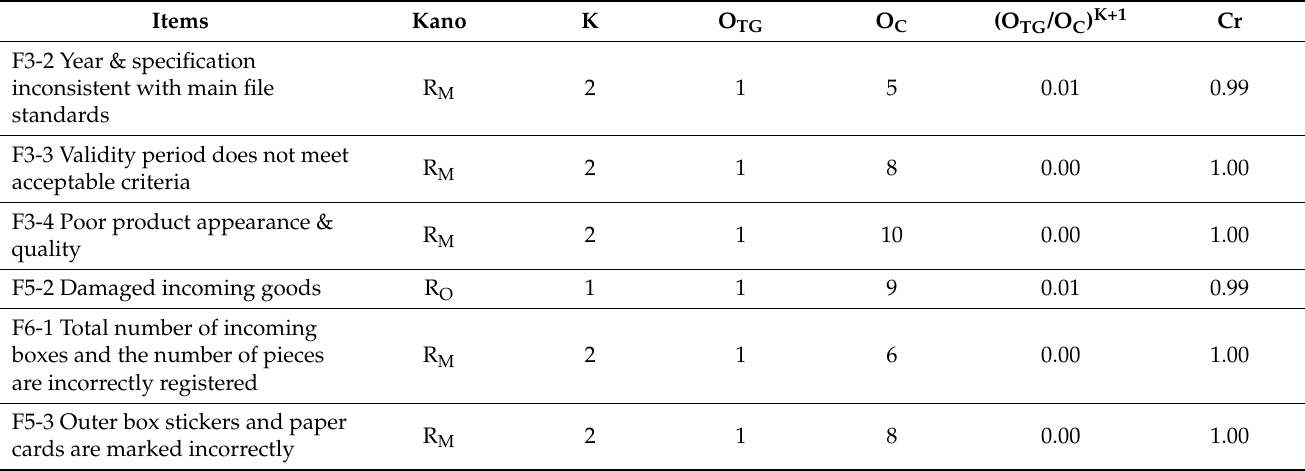
Table 4. Calculation result of correction rate (Cr).